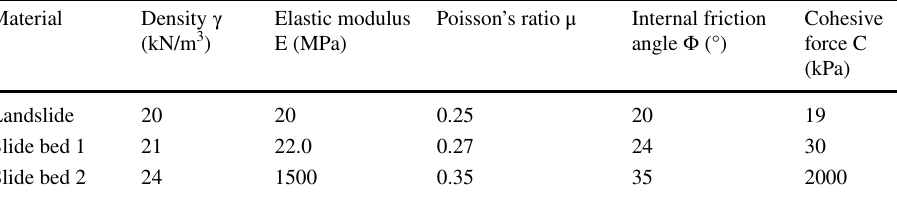
Table 4 Simulation slope